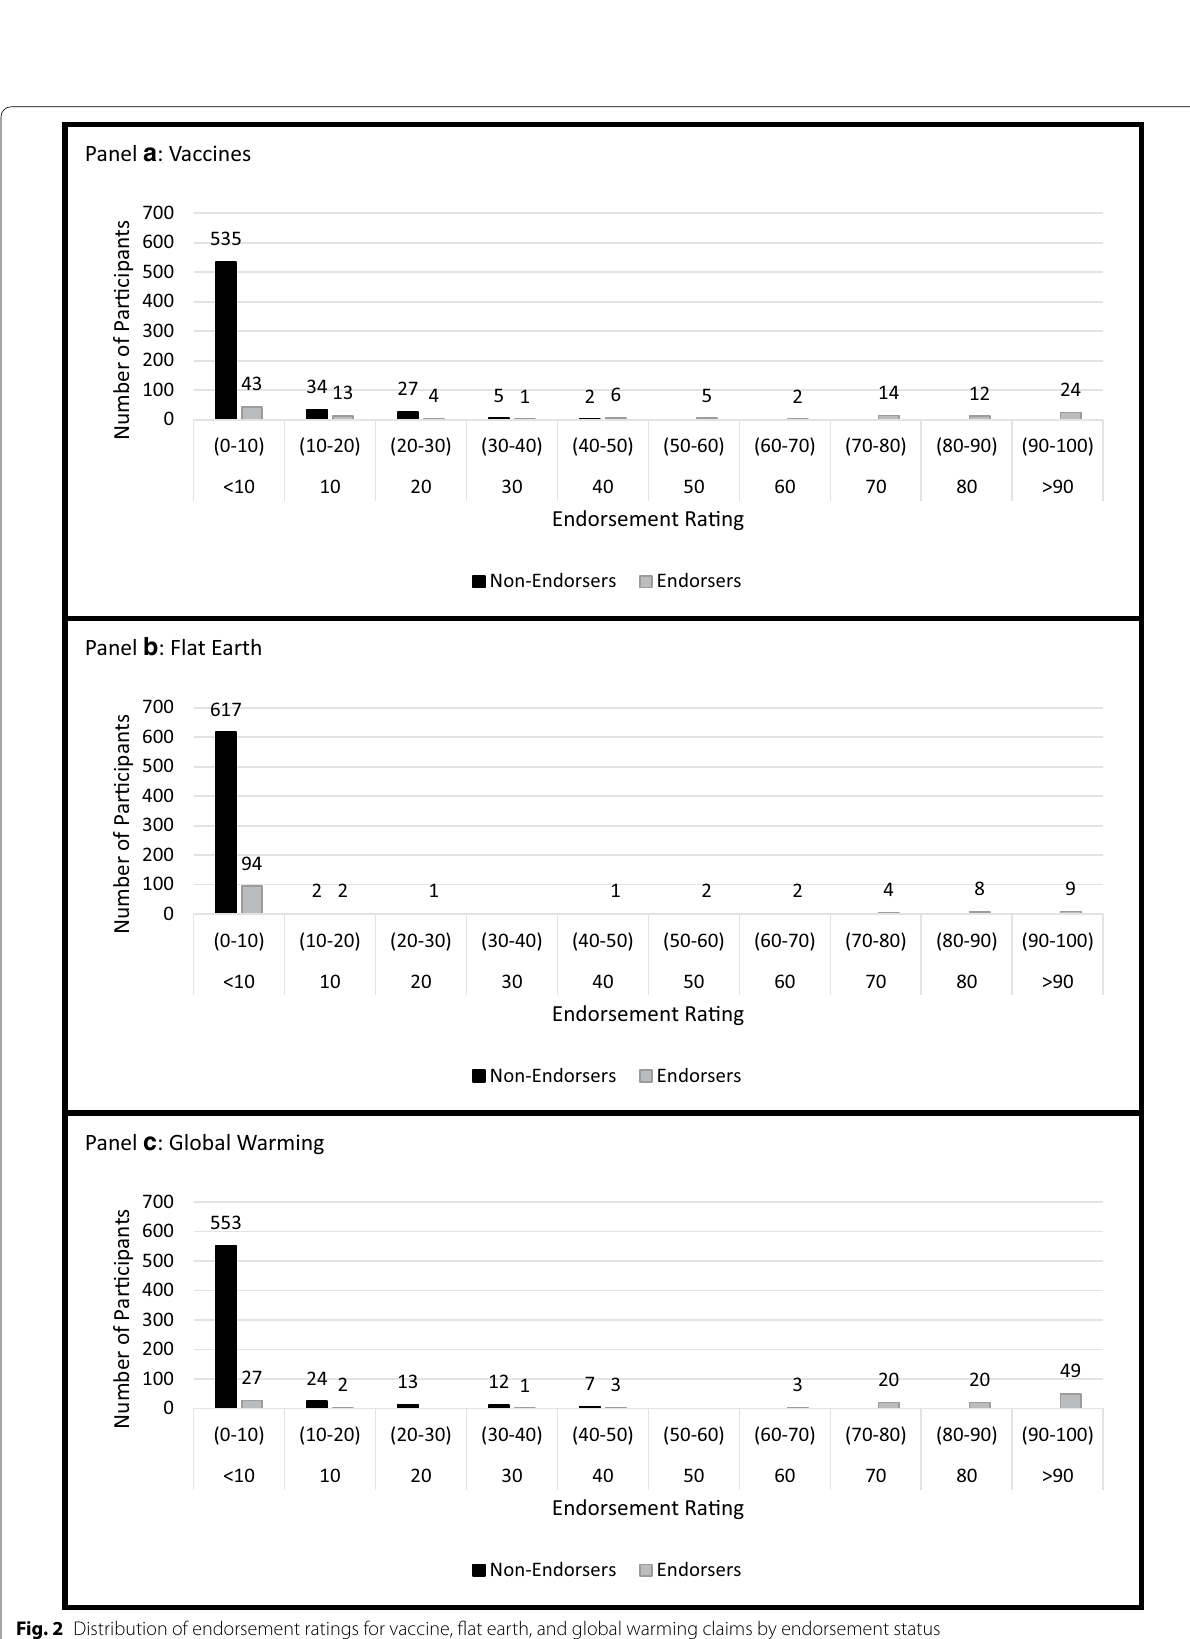
Fig. 2 Distribution of endorsement ratings for vaccine, flat earth, and global warming claims by endorsement